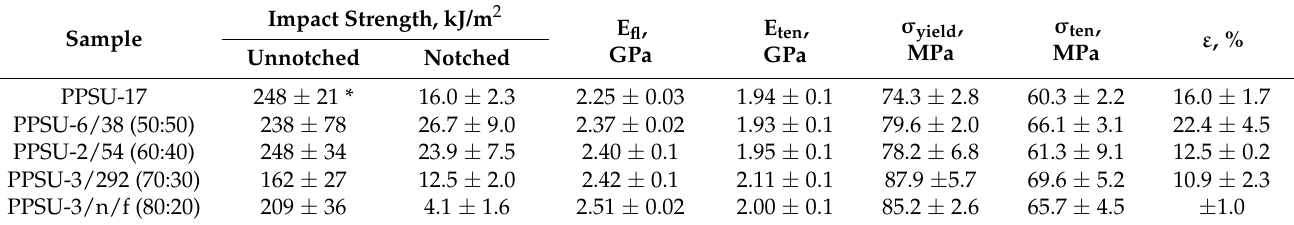
Table 3. Mechanical properties of PPSU